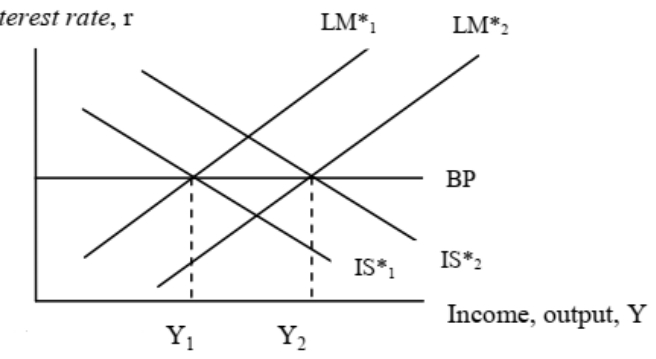
Figure 1: Fiscal Expansion Effect by National Income at Fixed Exchange Rate